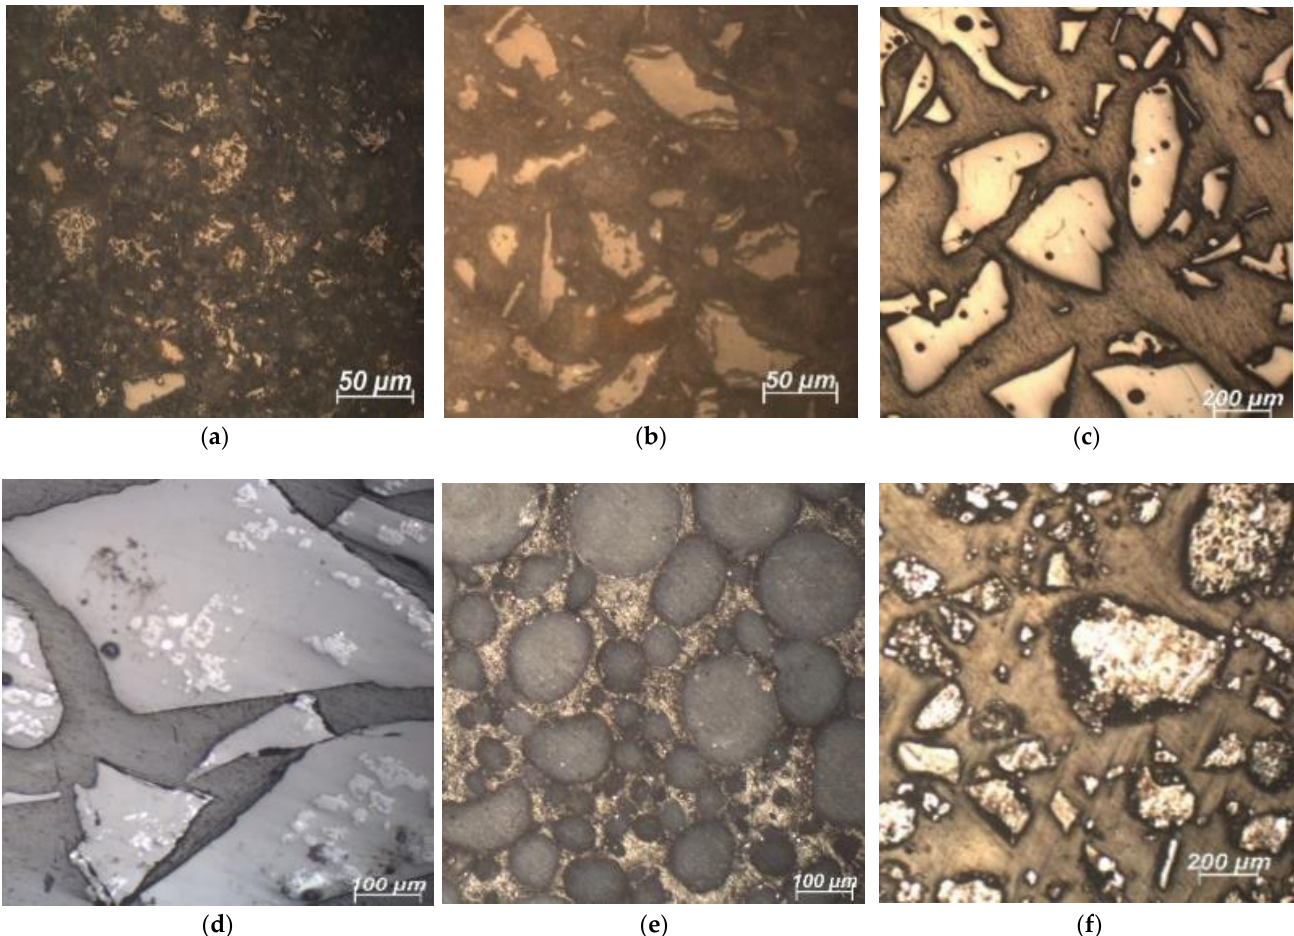
Figure 6. Metallographic results. ( a ) bauxite, ( b ) chamotte, ( c ) ground granulated blast furnace slag, ( d ) iron silicate, ( e ) silica fume, ( f ) steel slag.